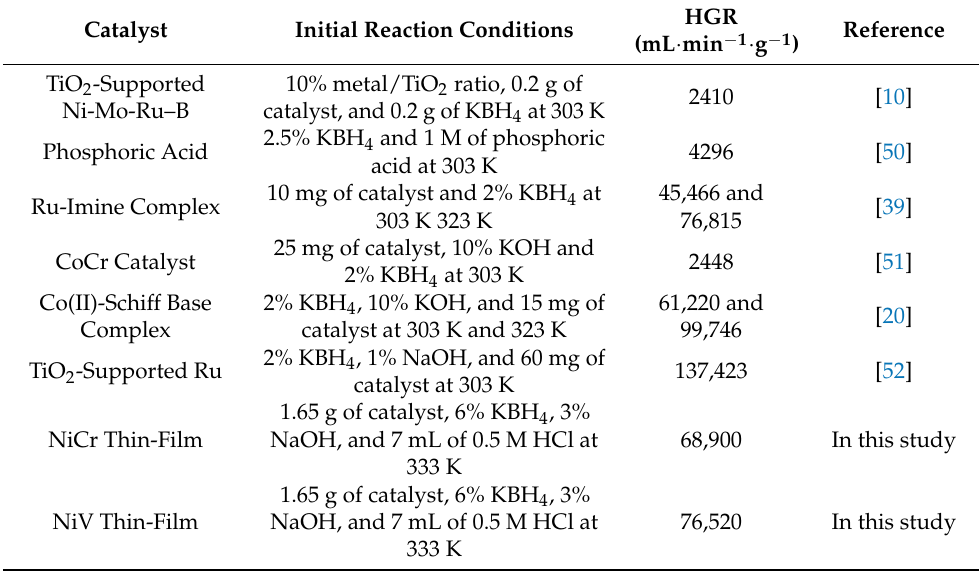
Table 5. Some catalysts for KBH 4